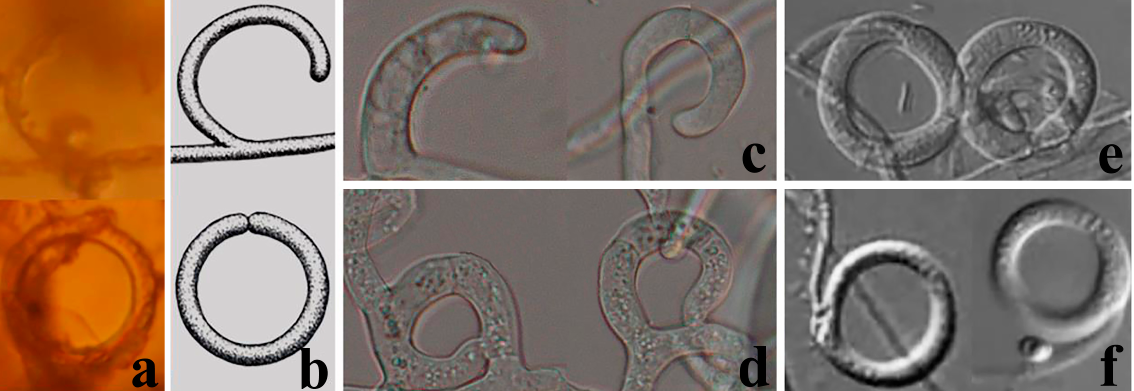
Figure 4. Trapping structure of fossil and extant carnivorous fungi. ( a , b ) Trapping structure of Palaeoanellus dimorphus : unicellular adhesive hyphal rings, reprinted with permission from Ref. [24]. 2023, John Wiley and Sons; ( c , d ) The early stages of adhesive networks produced by Arthrobotrys blastospora : single adhesive hyphal rings; ( e , f ) Trapping structure of some Dactylellina species: non-constricting rings [12].